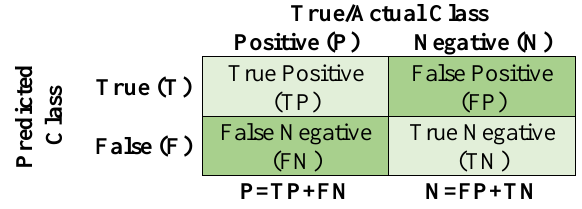
Figure 11. Confusion matrix for a binary problem.